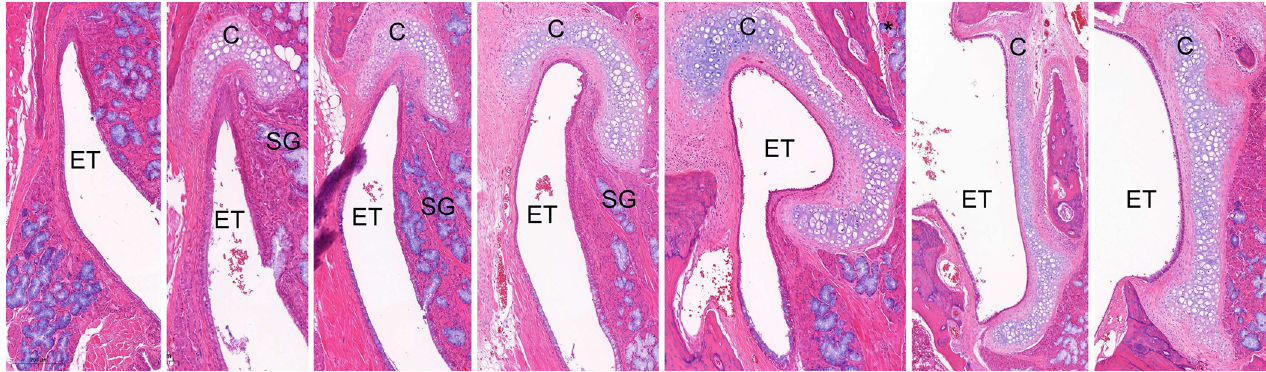
Fig 1. Normal histology of the right-side rat ET sectioned from the nasopharynx (left) to the tympanic bulla (right). The tissues were sectioned coronally at 200 μ m intervals, in the caudal direction from the medial to lateral sections. C, cartilage; ET, Eustachian tube; SG, submucosal glands (H&E stain). � The section in which the ET cartilage was in the form of a ‘comma’ shape, i.e. showing both the cartilaginous and nasopharyngeal epithelia, was selected for